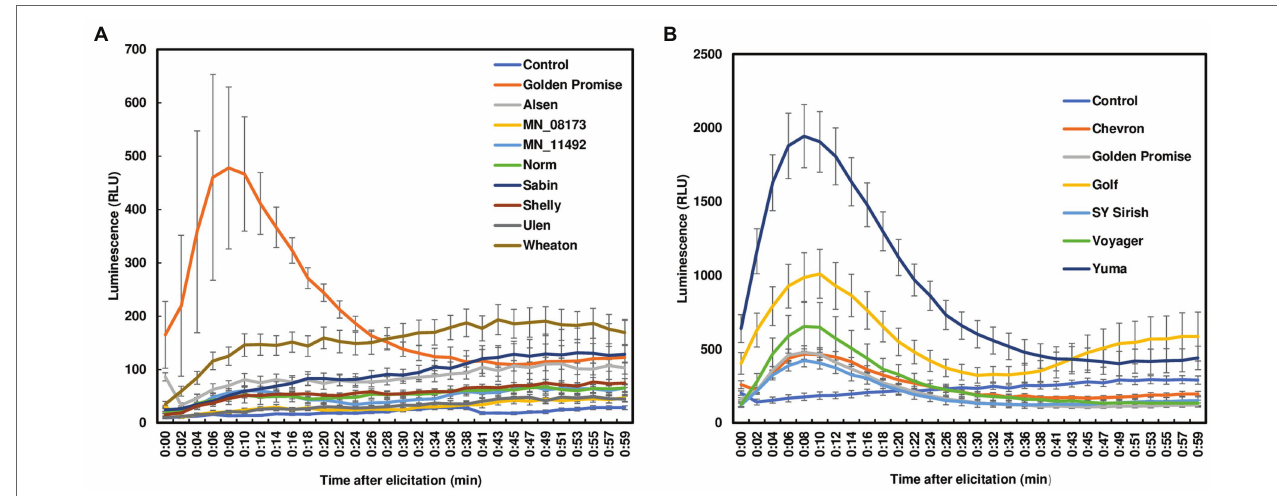
FIGURE 1 | ROS burst in wheat and barley leaves with chitin treatment. (A) Four FHB moderately resistant (Alsen, Sabin, Shelly, and MN-08173) and four FHB susceptible (Norm, MN11492, Wheaton, and Ulen) wheat varieties were tested. Golden Promise served as a positive control; (B) Barley varieties (Golden Promise, Voyager, Golf, Yuma510–510, Chevron, and Sy Sirish) were used. Leaves were collected from 7- to 12-day-old plants. Approximately 3 × 3 mm leaf pieces were sliced and treated with crab chitin (100 μ g/ml). ROS were monitored using a chemiluminescence assay with L012 as a substrate. The plates were run on a 96-well plate reader and signals (RLU, relative light unit) were recorded for about 60 min. The data represent means ± standard error ( n = 12). The experiments were repeated at least three times with similar